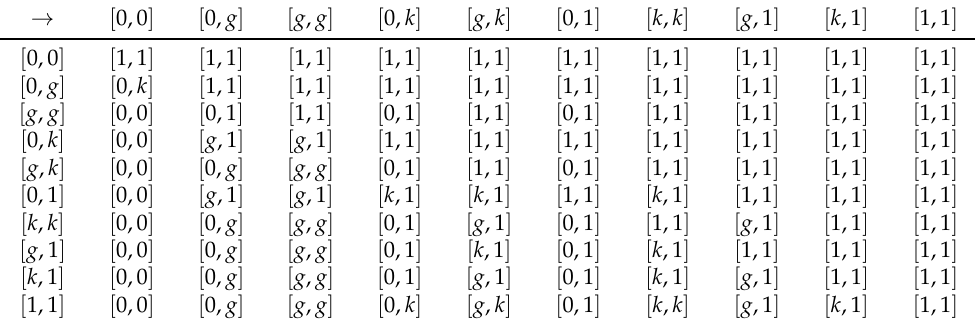
Table 5. The operator → of algebra in Example 7.